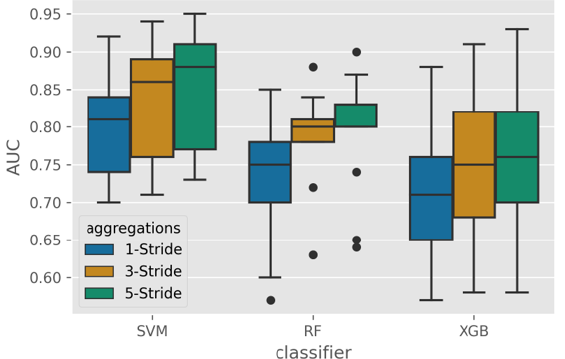
Figure 14. AUC distribution of test subjects using increasing stride aggregations for prediction for each